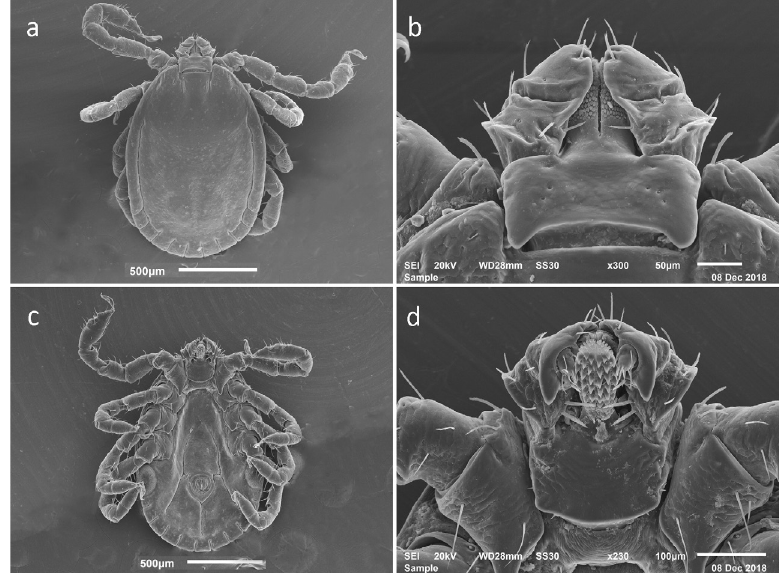
Figure 3. SEM photos of nymphal H. longicornis from a colony started with specimens from Jeju- teukbyeoljachido, Republic of Korea (Accession # RML48803). a dorsal full body b dorsal capitulum c ventral full body d ventral capitulum.